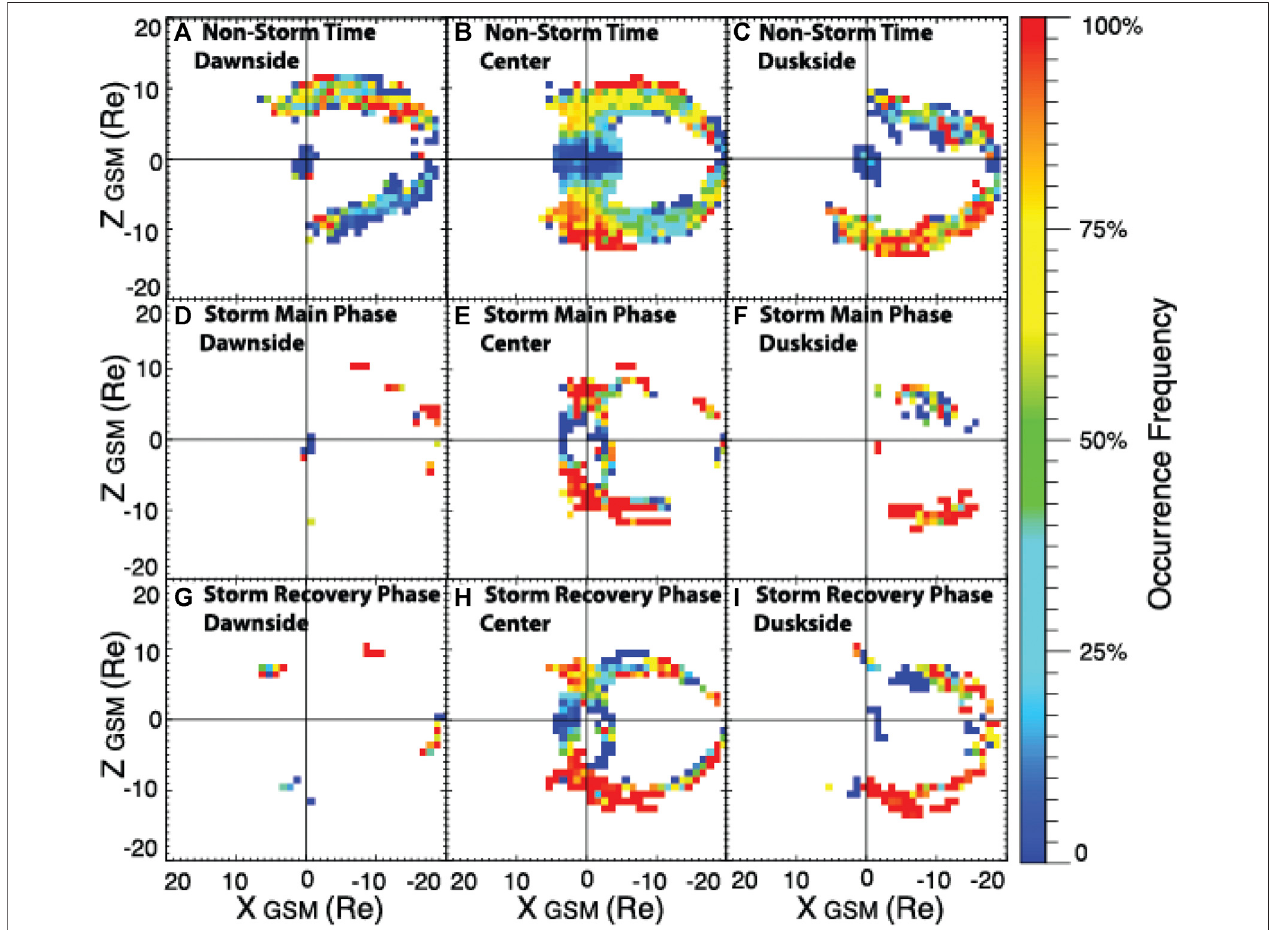
FIGURE 4 | Observations from the Cluster satellite of out fl owing O + ions from the polar cusp seen in the lobes of the magnetotail.